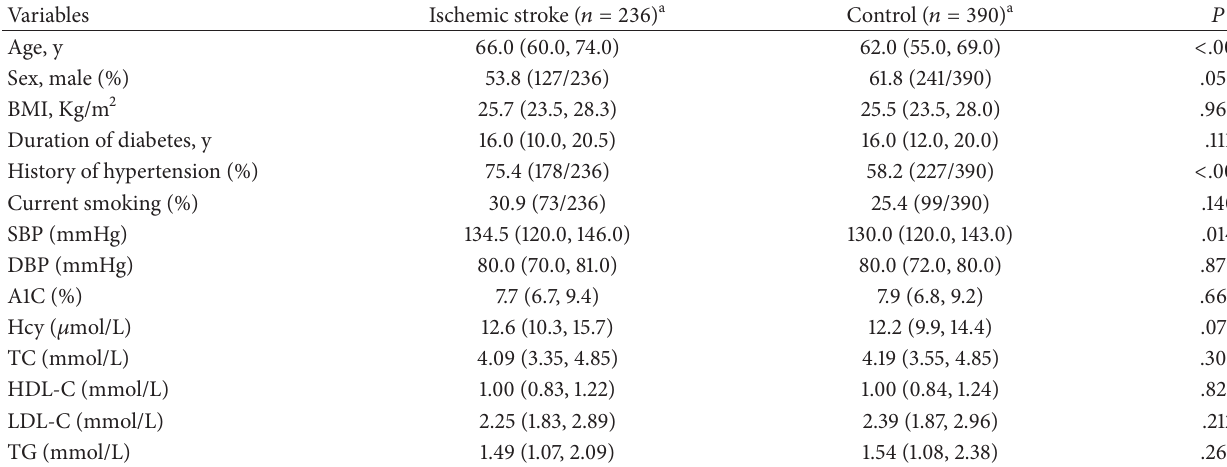
Table 1: Characteristics of T2DM in ischemic stroke cases and control